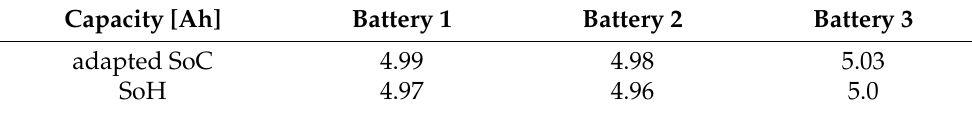
Table 13. Remaining Capacity at the end of the month of simulation.